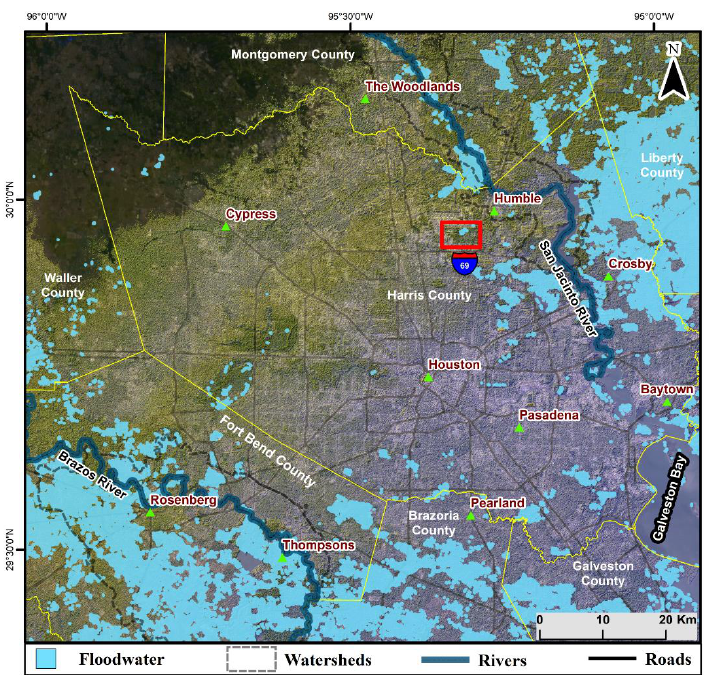
Figure 4. Flood mapping of Houston and its surrounding areas following Tropical Storm Imelda (2019) derived using Sentinel-1 data. The results demonstrate the reliability of the developed CCD-based approach for identifying the recurrently flood-affected areas of Houston and its surrounding areas using datasets from earlier severe weather events (i.e., Tax Day storm and Hurricane Harvey). The George Bush International Airport (red box) area was selected as a test site to demonstrate the change in coherence observed as a result of flooding following the three severe weather events. Remote Sens. 2020 , 12 , x FOR PEER REVIEW